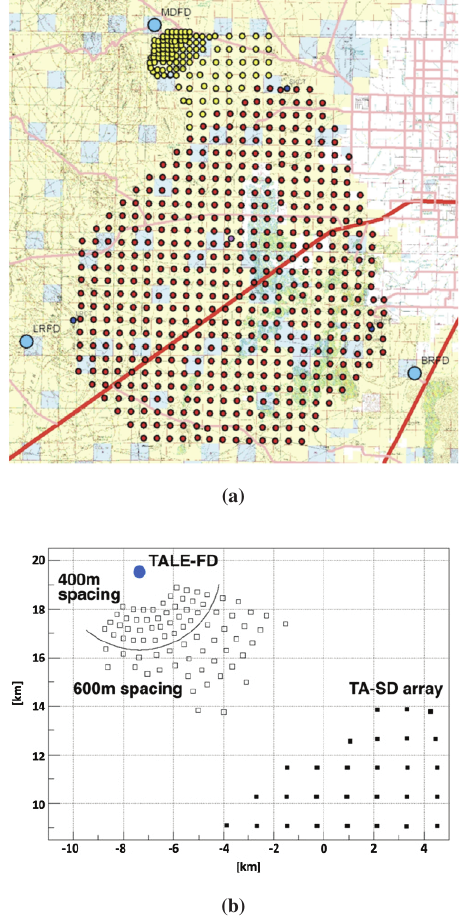
Figure 1: (a)General map of the TA experiment site. The loca- tions of the TA-SDs are shown as red circles and the locations of the three TA-FD stations are indicated by light blue circles. Yellow circles show the location of the TALE-SDs. The TALE-FD station is located at the MD site. (b)The layout of the TALE detectors. Open square boxes ( (cid:3) ) represent the locations of the TALE- SDs and blue circle ( • ) correspond to the MD / TALE- FD station. Black boxes ( (cid:4) ) repesent the locations of the TA-SDs.